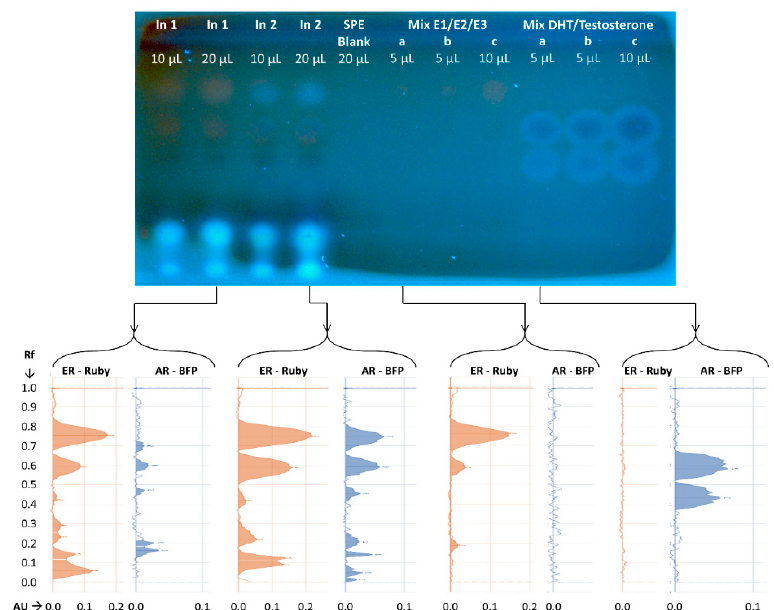
Figure 9. Simultaneous detection of androgenic and estrogenic effects in extracts of two wastewater treatment plants (WWTP) influent (In1, In2; 10 μ l and 20 μ l each) by a 1:1 mix of two yeast bioreporter strains, ER-Ruby and AR-BFP. An estrogen mix consisting of E1 (a: 0.1, b: 0.2 and c: 0.4 ng), E2 (0, 20 and 40 pg) and E3 (1, 2 and 4 ng), and an androgen mix of DHT (a: 10, b: 25 and c: 50 ng) and testosterone (10, 25 and 50 ng) were separated on the same plate. Ethanol served as blank on track 10. A two-step chromatographic development was performed, with 100% methanol for the first 20 mm, and an ethyl acetate/n-hexane 1:1 mixture for the next 70 mm. Top: plate image displaying the fluorescent signal using a TLC Visualizer 2 at λ ex = 366 nm following an 18 h exposure at 30 °C. Signals were enhanced using the enhancement tool of the visionCATS software. Bottom: scans of the individual tracks for both ER-Ruby- and AR-BFP-fluorescence (TLC Scanner settings: Ruby: λ ex = 525 nm, a 540 nm cutoff filter; BFP: λ ex = 396 nm a 400 nm cutoff filter).